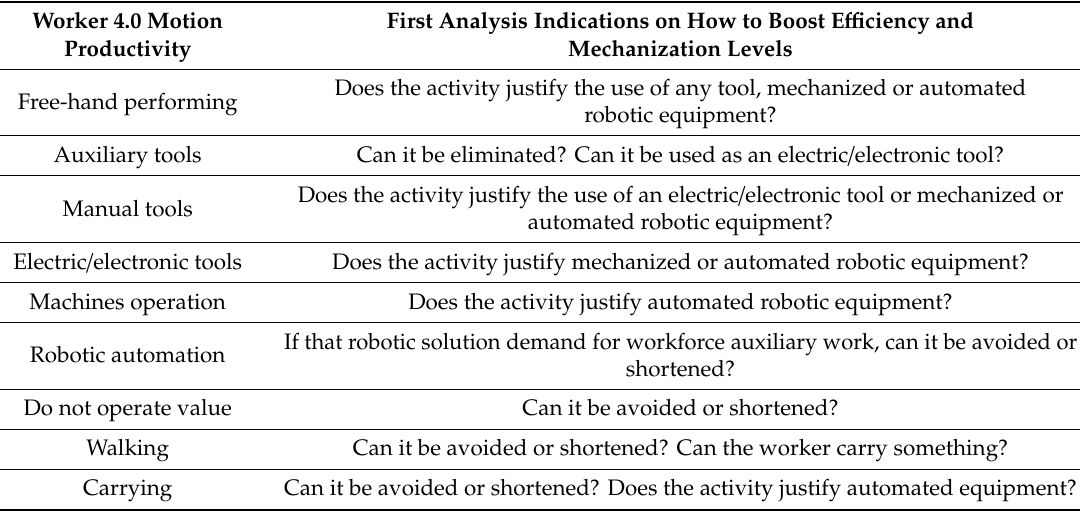
Figure 5. Worker 4.0: Flowchart to increase efficiency. Table 5. Worker 4.0: motion productivity (W4MP)-improving process.